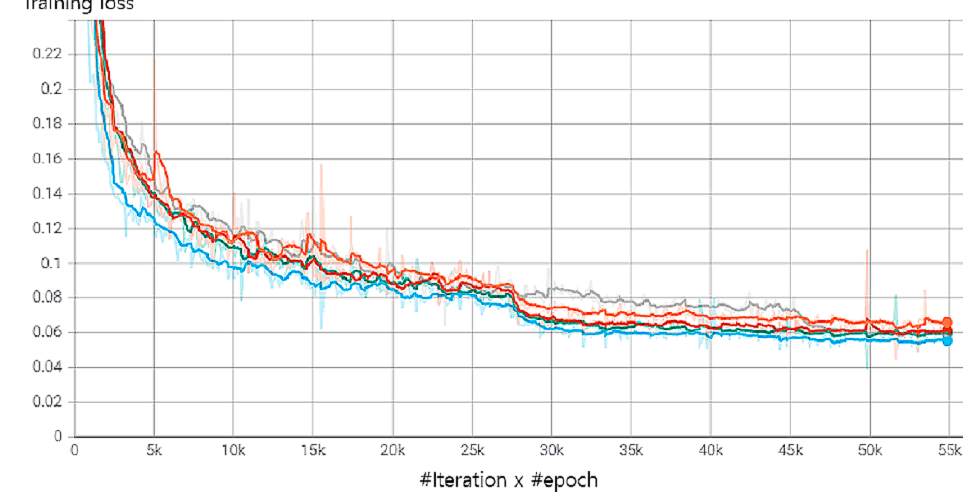
Figure 5. Training loss graphs.